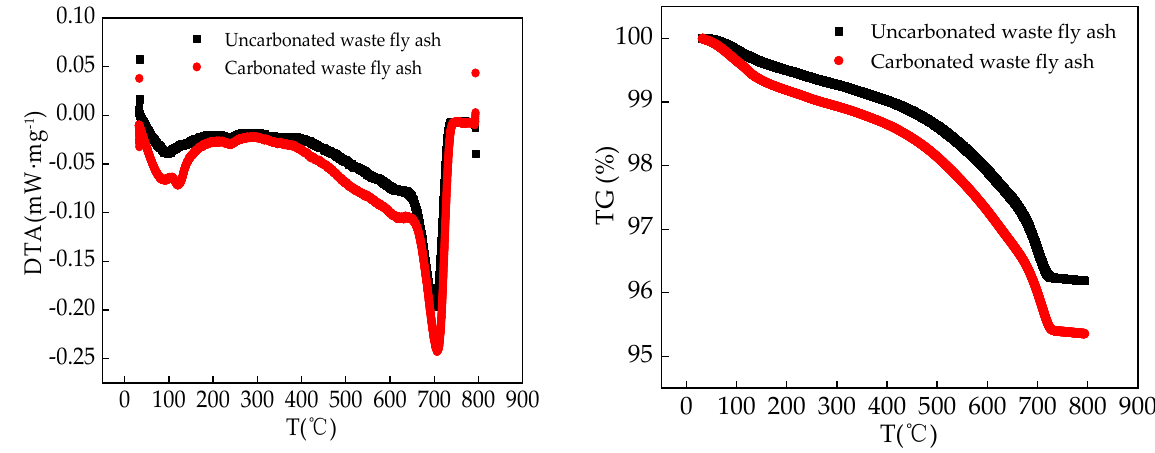
Figure 10. Thermogravimetric analysis curves of incinerated waste fly ash particles.